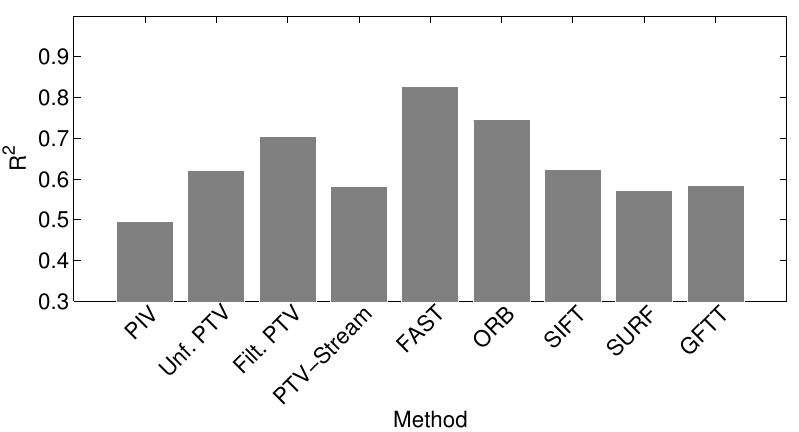
Figure 8. R 2 values computed between all the approaches and the benchmark current meter data.